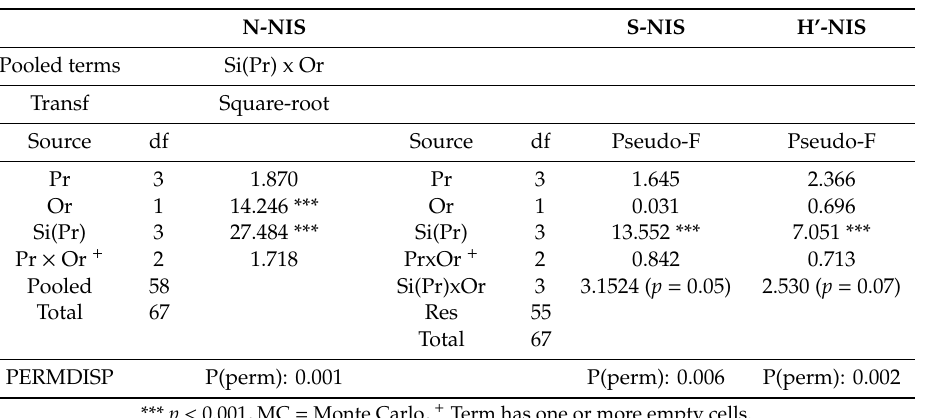
Table8. Univariateanalysisofvarianceofnon-indigenous(NIS)componentofmacrofoulingassemblage across “Pressure” levels (Pr), “Origin of biofilms” (Or) and Sites (Si(Pr)) after 15 weeks of panel deployment. Analyses are based on Euclidean distances of untransformed data of S and H’, and on square root transformed data of N-NIS. Pair-wise comparisons were performed when significant di ff erences were found (see Supplementary Materials Table S4). Abbreviations as in Tables 2 and 5.